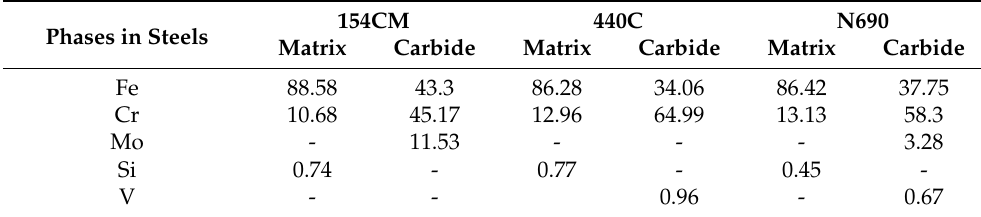
Table 2. Distribution of major metallic elements in steels